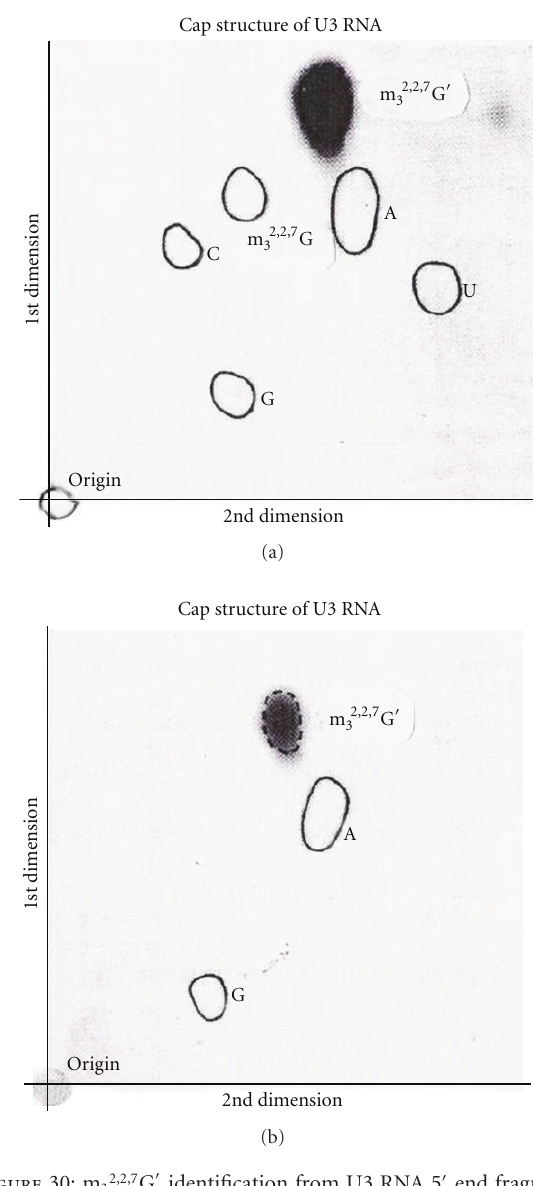
Figure 30: m 32,2,7 G (cid:2) identification from U3 RNA 5 (cid:2) end fragment [58]. The [ 3 H]-labeled U3 RNA 5 (cid:2) fragment obtained by RNase T 1 and RNase A was digested with snake venom phosphodiesterase and alkaline phosphatase. The nucleoside mixture was separated by two- dimensional thin layer chromatography with standard nucleoside mixture in (a) and with the trialcohol derivative of m 32,2,7 G (cid:2) in (b). The released nucleoside trialcohol derivative was identified as m 32,2,7 G (cid:2) by